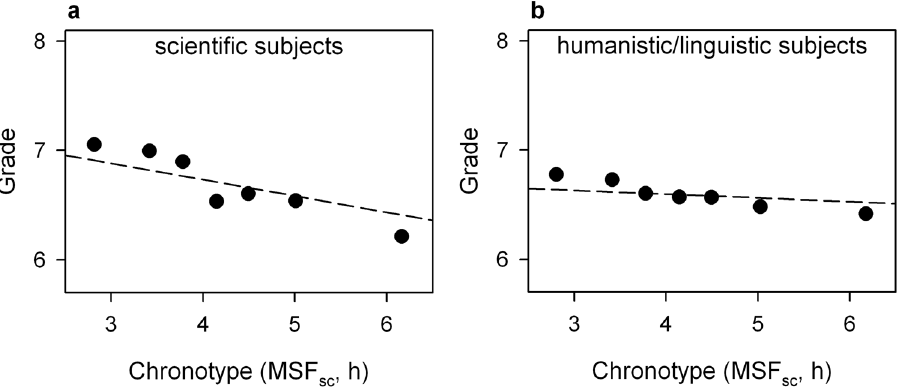
Figure 4. Influence of chronotype (MSF sc ) on grades by subject area. Data points represent mean grades with standard error of the mean (SEM). Since the SEM were very small, error bars are not always visible. Mean grades were calculated for 7 equal-sized groups of students based on chronotype (lower numbers correspond to earlier chronotypes and higher numbers to later chronotypes, respectively). Regression lines representing the association between chronotype and grades (raw data) were calculated with multilevel mixed modelling separately per each subject. The raw data are shown in Supplementary Figure S3. The influence of chronotype on grades was significantly stronger for scientific subjects (biology, chemistry, physics, and mathematics) ( a ) compared with humanistic/linguistic subjects (Dutch, English, geography, and history) ( b